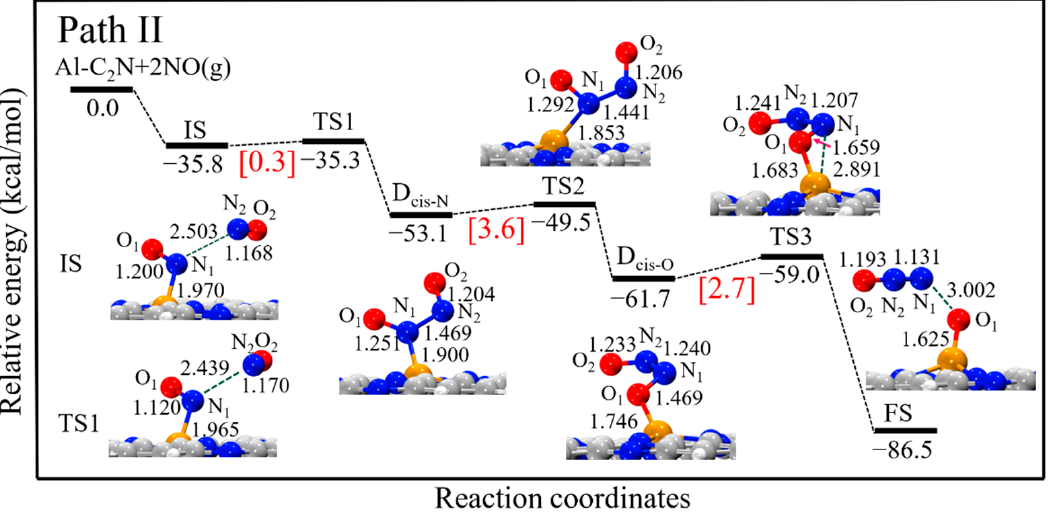
Figure 5. The energy profiles and corresponding structures of the D cis-N and D cis-O dimer reduction process on Al-C 2 N. All bond lengths are in Å.